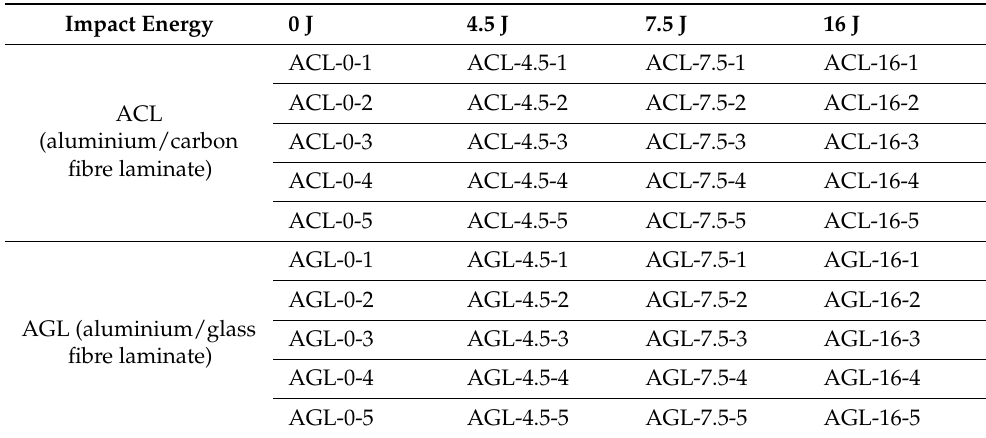
Table 1. Designation of FML plates prepared for LVI and CAI tests.